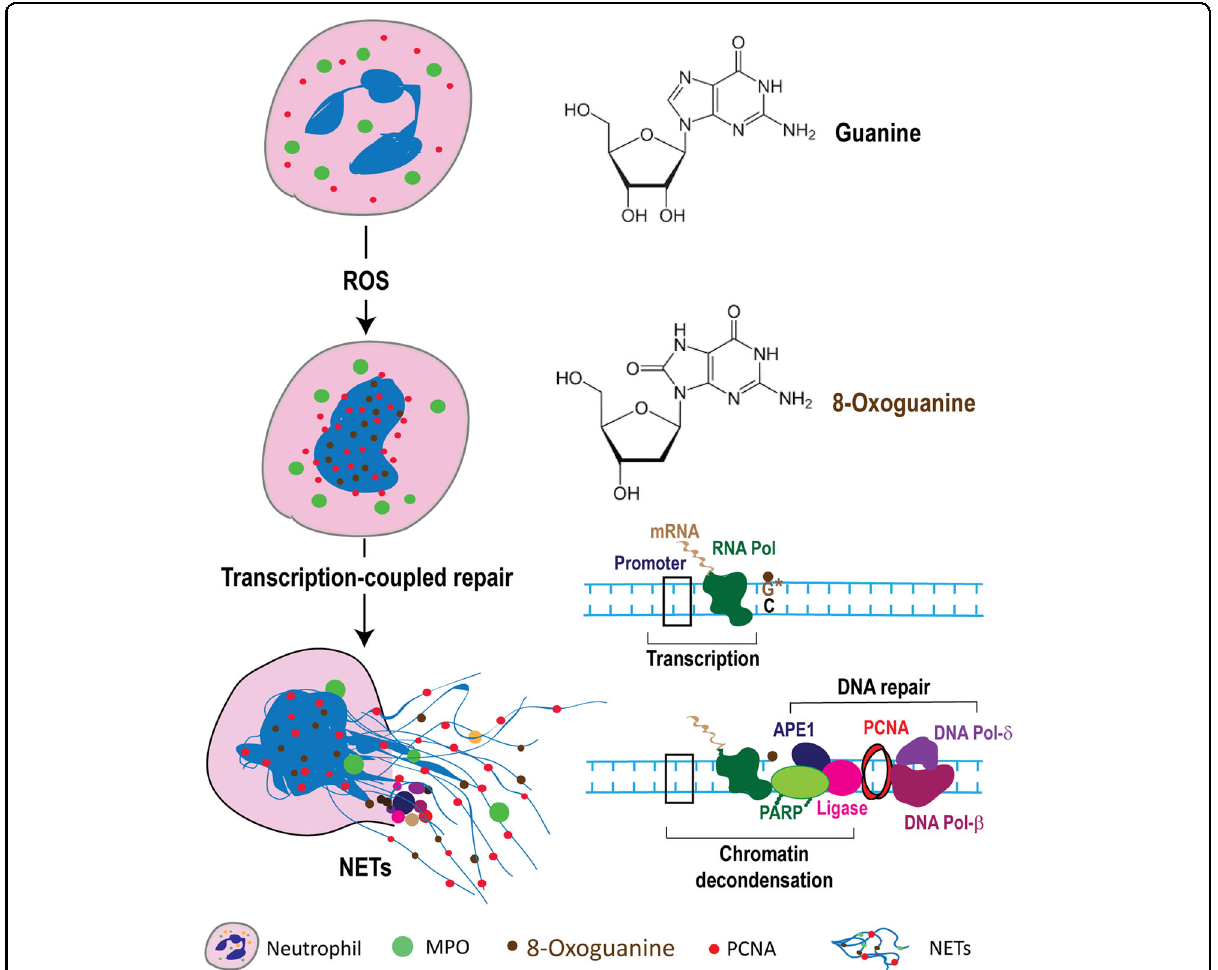
Fig. 5 Summary fi gure. Diagram showing the role of DNA damage repair during NETosis in the context of the other known components of the NETosis